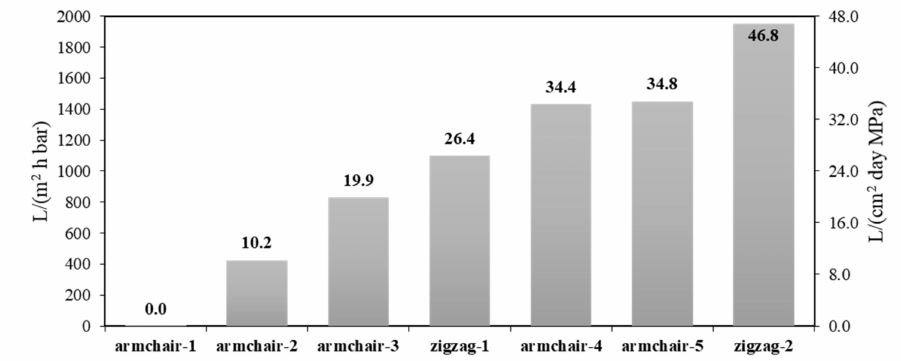
Figure 3. Theproductivityofmodelmembranes. ThenumbersabovethebarsshowvaluesinL / (cm 2